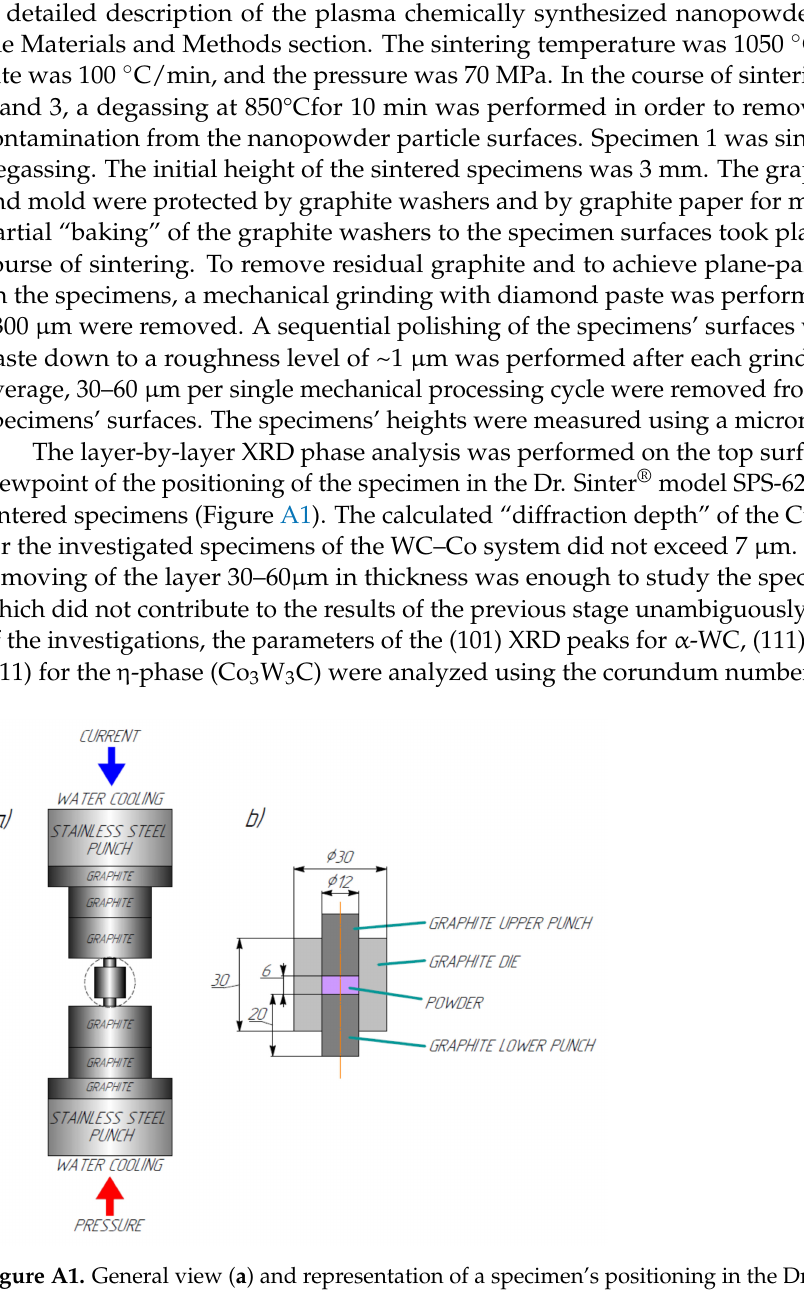
Figure A1. General view ( a ) and representation of a specimen’s positioning in the Dr. Sinter ® model SPS-625 setup ( b